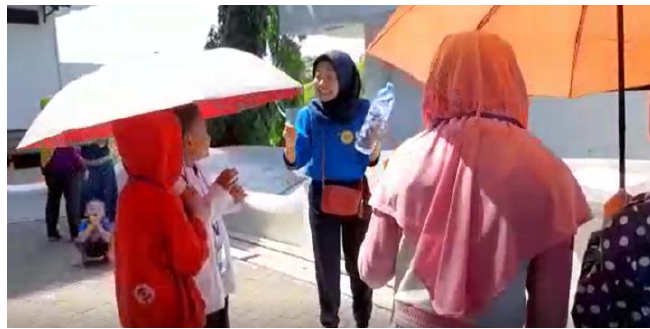
FIGURE 9 | Learning Weather Forecast Contextually